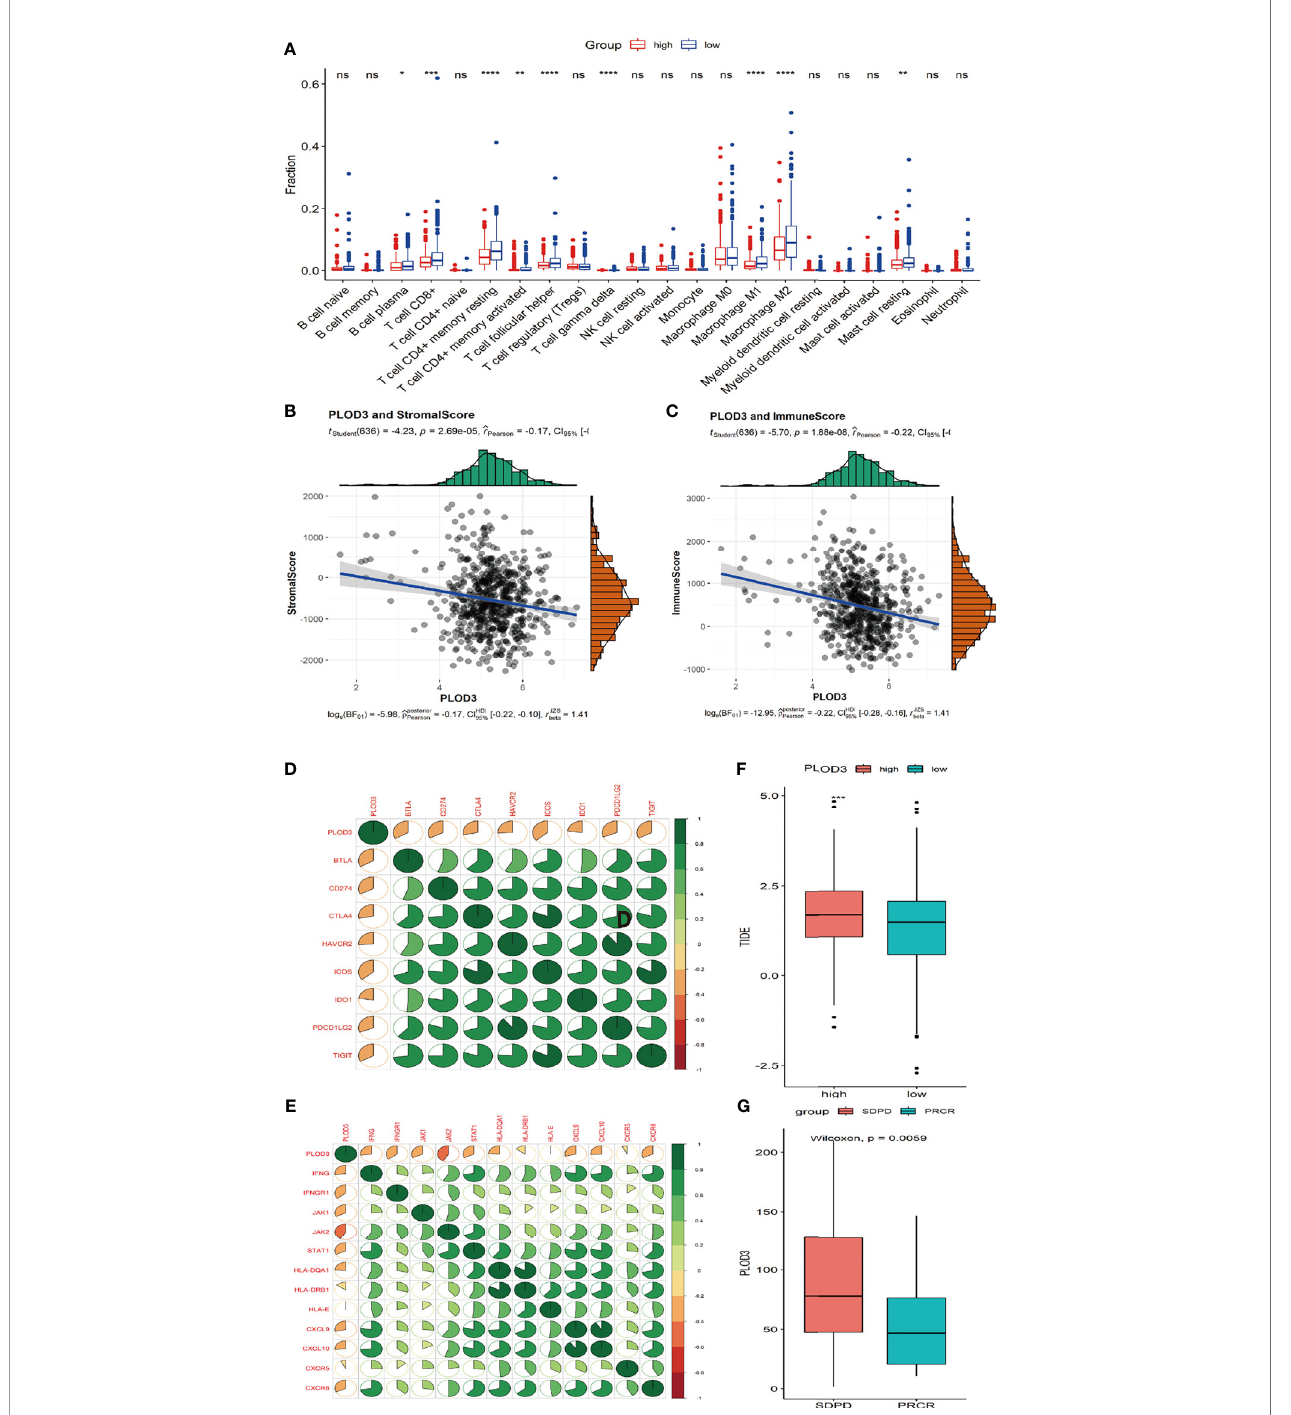
FIGURE 5 | Correlation analysis of immune cell in fi ltration and PLOD3 in CRC. (A) Immune cell in fi ltration levels in high and low PLOD3 expression groups from TCGA-CRC cohort. (B) Correlation analysis of StromalScore and PLOD3 in TCGA-CRC cohort; (C) Correlation analysis of ImmueScore and PLOD3 in TCGA-CRC cohort. (D) Correlation between PLOD3 and immune checkpoint levels; green represents positive correlation, red represents negative correlation; color intensity is positively related with the strength of the correlation. (E) Correlation between PLOD3 and immune related genes; green represents positive correlation, red represents negative correlation; color intensity is positively related with the strength of the correlation. (F) Boxplot shows the TIDE score for high and low PLOD3 expression groups. Data are expressed as the mean ± SD. * p < 0.05, ** p < 0.01, *** p < 0.001, **** p < 0.0001. ns, not signi fi cant. (G) Boxplot shows the PLOD3 expression for immunotherapy response (CR and PR) and non- response groups (SD and PD). CR, complete response; PR, partial response; SD, stable disease; PD, progressive